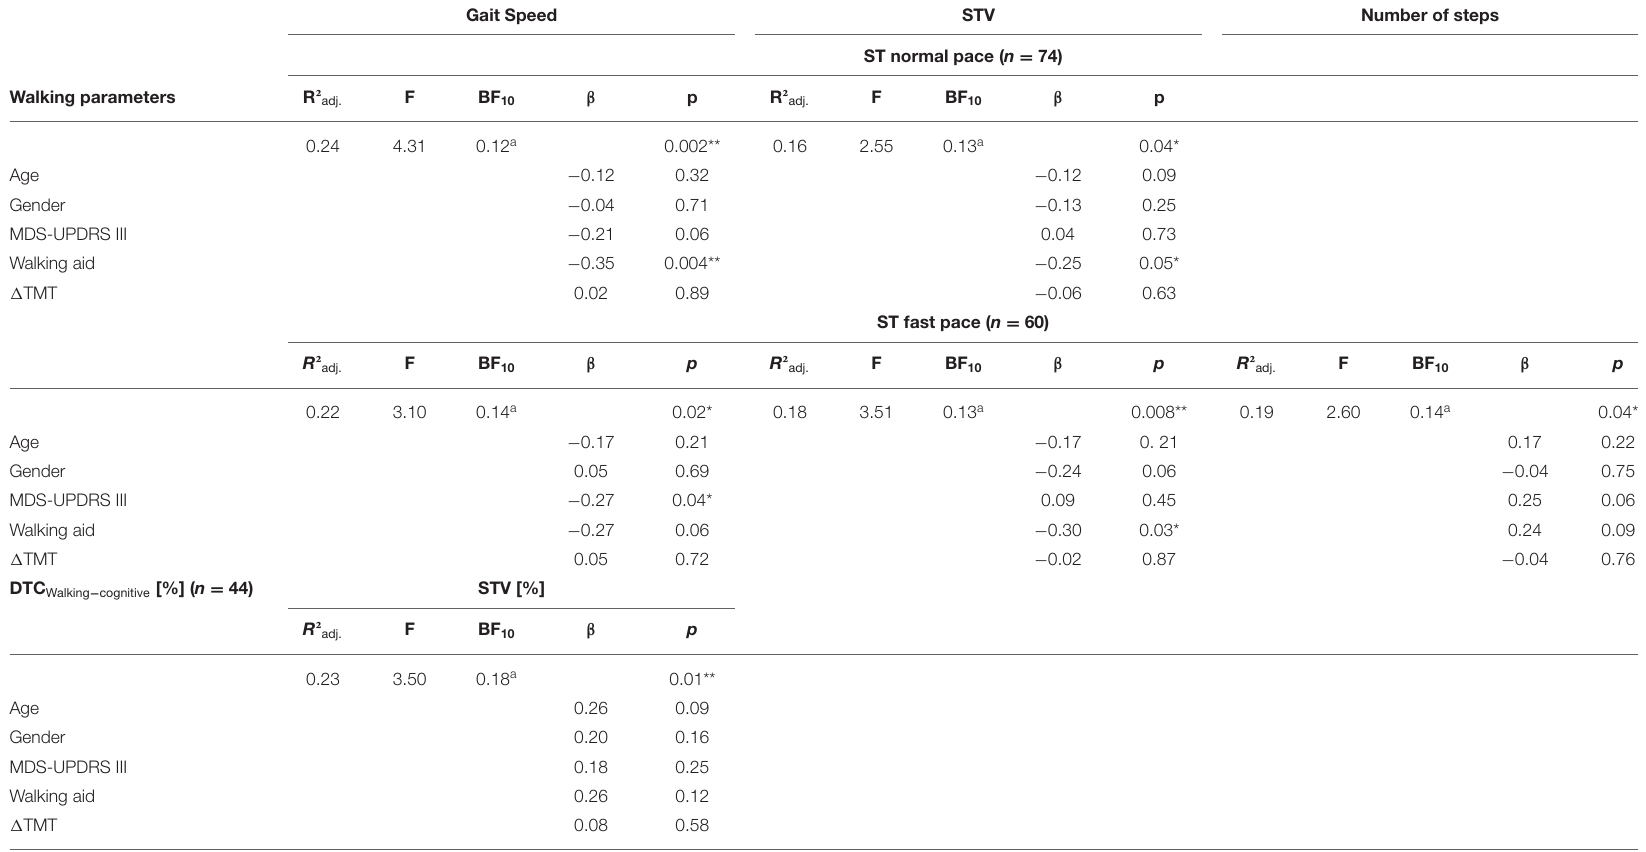
TABLE 2 | Multiple linear regression models and Bayes factors for significant walking parameters and their DTC Walking . Gait Speed STV Number of steps